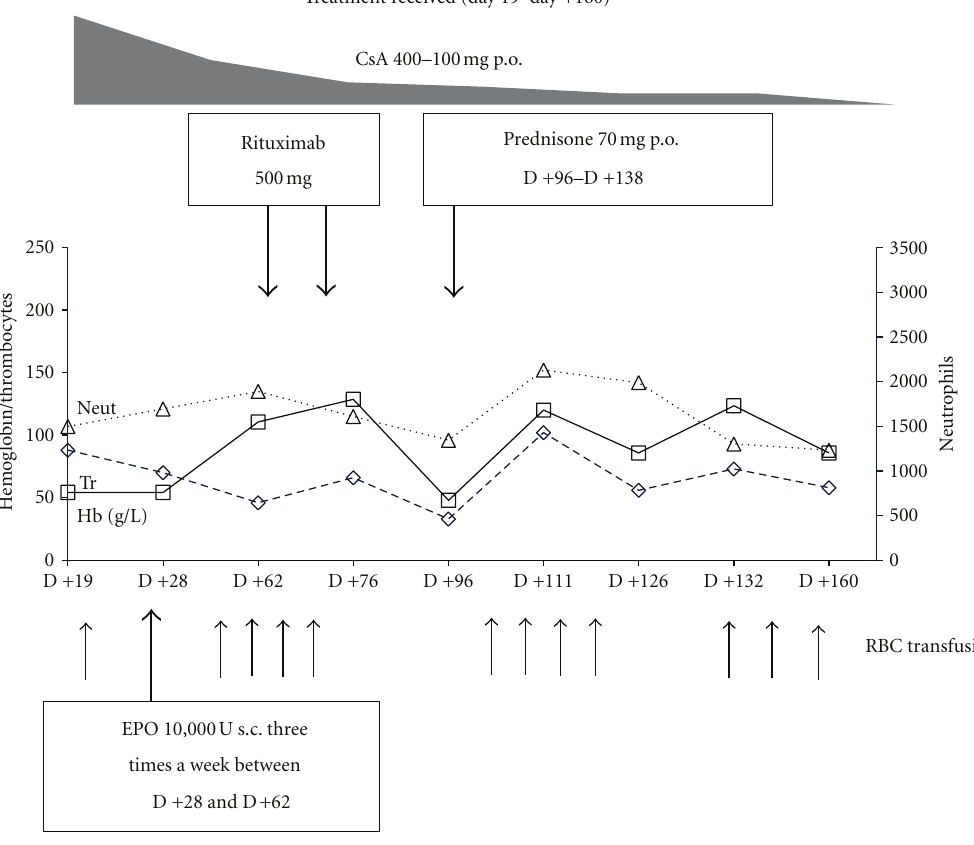
population of the donor’s MSC at a dose of 1 . 2 × 10 ∗ 6/kg, derived from a small marrow aspirate sample which was cotransplanted on day 0. Neutrophil engraftment was seen on day +16. However, mixed chimerism was confirmed